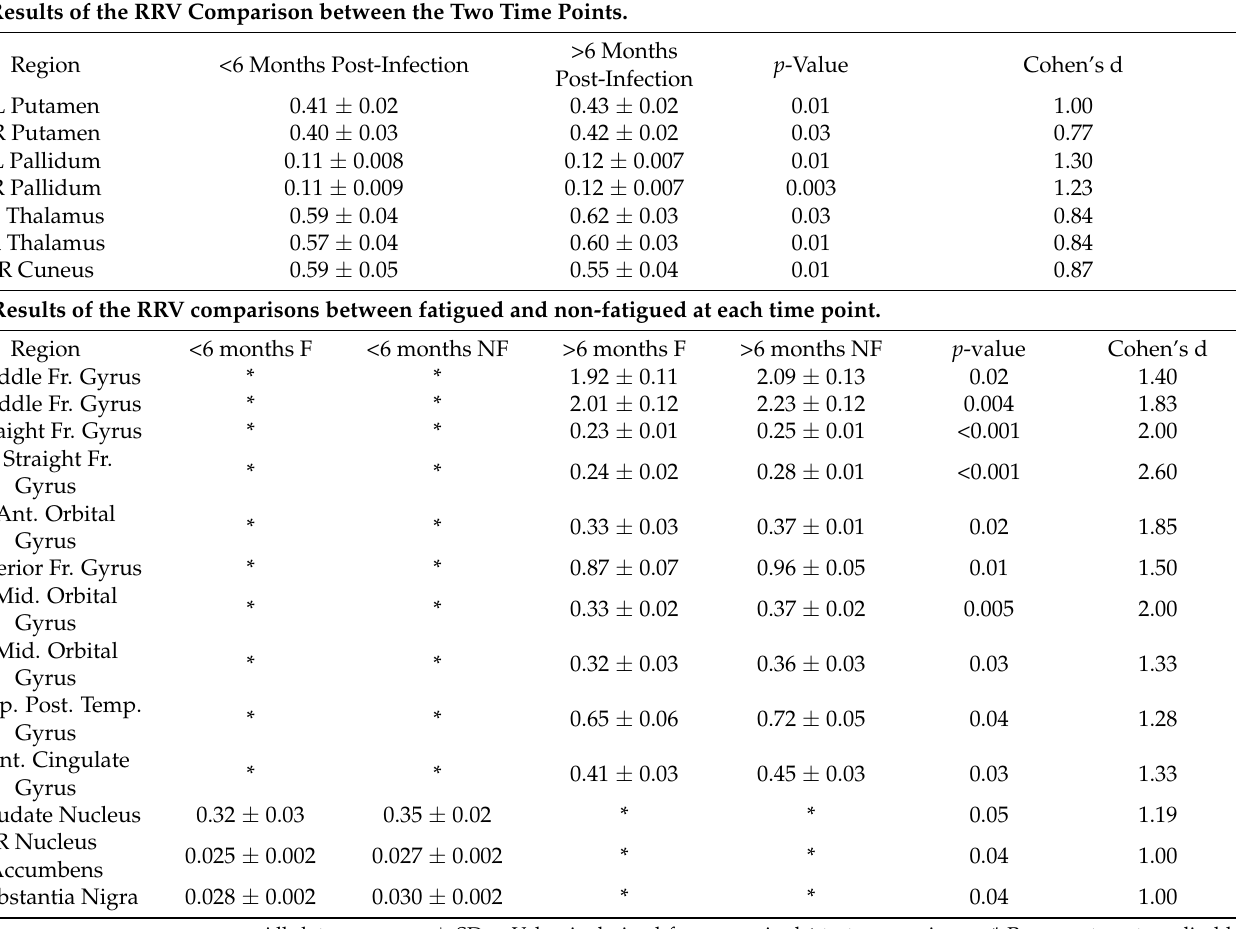
Table 2. ( a ). Results of the RRV comparison between the two time points. ( b ). Results of the RRV comparisons between fatigued and non-fatigued at each time